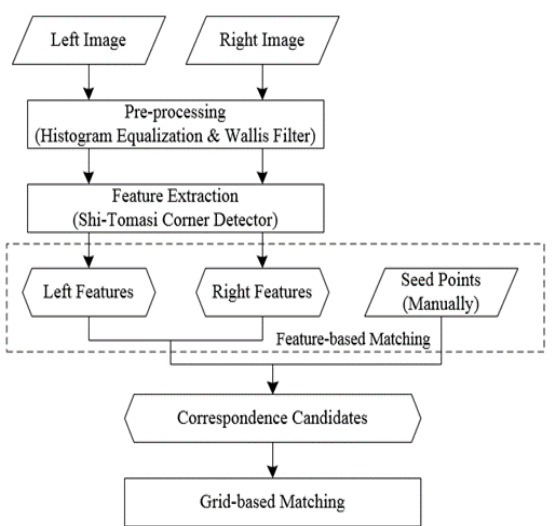
Figure 3. Flowchart of Feature and Grid-Based Image Matching with Constraints